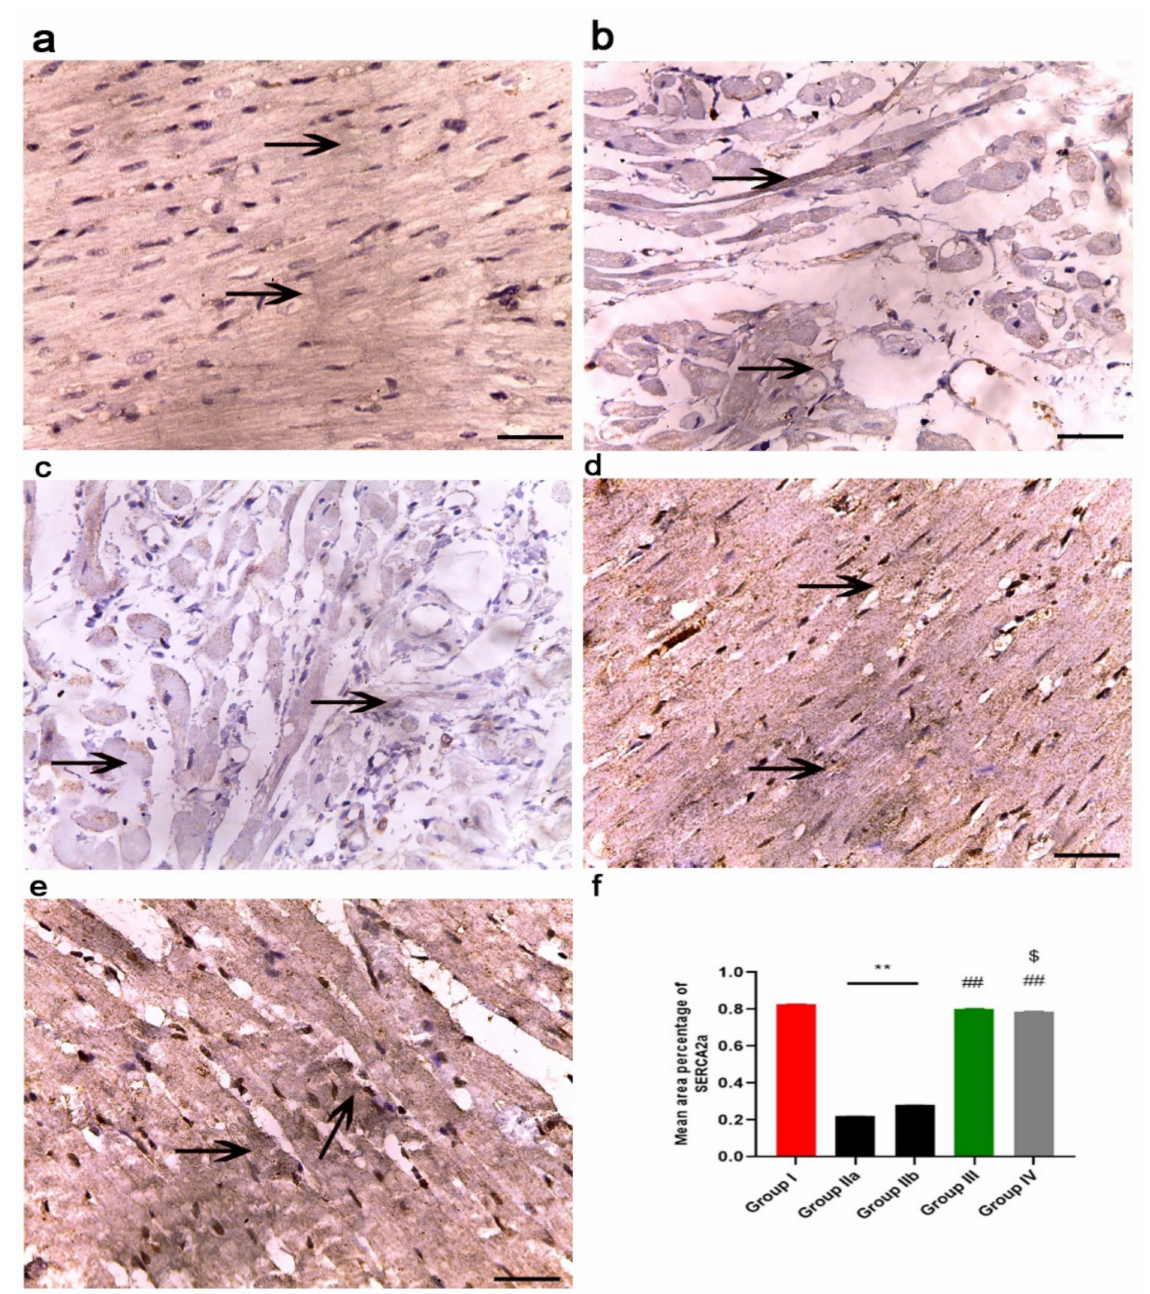
Figure 15. Representative photomicrographs of SERCA2 immuno-stained sections from the left ventricle of the myocardium of the different experimental groups: ( a ) Group I (control group) showed strong immuno-expression of SERCA2 in the myocardium; ( b ) Group IIa (DOX/Trz group) showed minimal immuno-expression of SERCA2 in the myocardium; ( c ) Group IIb (recovery group) showed minimal immuno-expression of SERCA2 in the myocardium; ( d ) Group III (prophylactic group) showed strong immuno-expression of SERCA2 in the myocardium; ( e ) Group IV (curative group) showed moderate immuno-expression of SERCA2 in the myocardium; and ( f ) Histogram representing the mean area percentage of SERCA2 immuno-reaction in all experimental groups. **, significant compared to Group I at p < 0.01; ##, significant compared to Group II at p < 0.01; $, significant compared to Group III at p < 0.05; n =